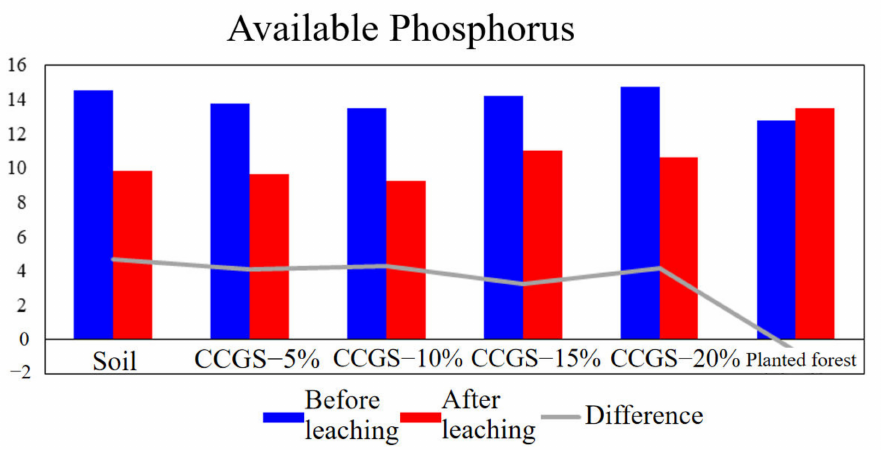
Figure 17. Effect of CCGS on Available